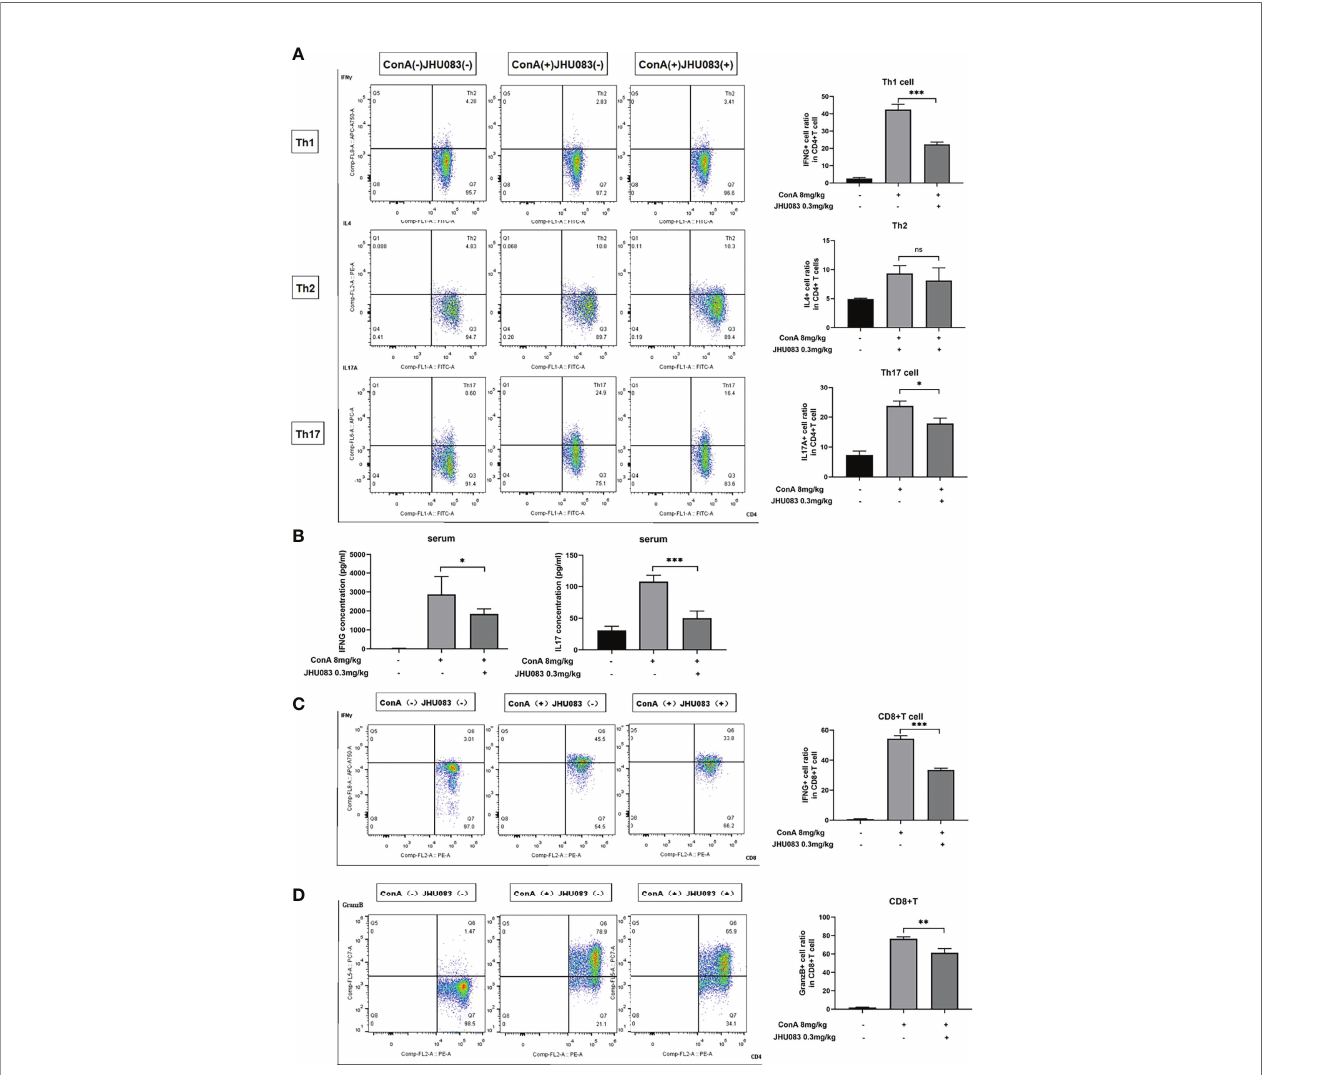
FIGURE 3 | JHU083 inhibited T cells differentiation in vivo . Mice of Vehicle-AIH and JHU083-AIH group were intravenously injected with 8ml/kg ConA, and Vehicle- WT group was injected with normal saline of equal volume. JHU083-AIH group was gavaged with 0.3mg/kg JHU083 24h and 1h before ConA injection, and Vehicle- WT and Vehicle-AIH group were treated with equal vehicle at the same time points. (A) Flow cytometry was applied to analyze the Th1 cell percentage via IFN g expression, the Th2 cell percentage via IL4 expression, and the Th17 cell percentage via IL17A expression. (B) ELISA was applied to analyze serum IFN g (Th1 cells) and IL17 (Th17 cells) secretions. Flow cytometry was also applied to analyze the differentiation of CD8(+) T cells into cytotoxic T lymphocytes, evidenced by secreting IFN g (C) and Granzyme (D) . Data were expressed as means ± SEM. * P < 0.05, ** P <0.01, and *** P <0.001. ns, not signi fi